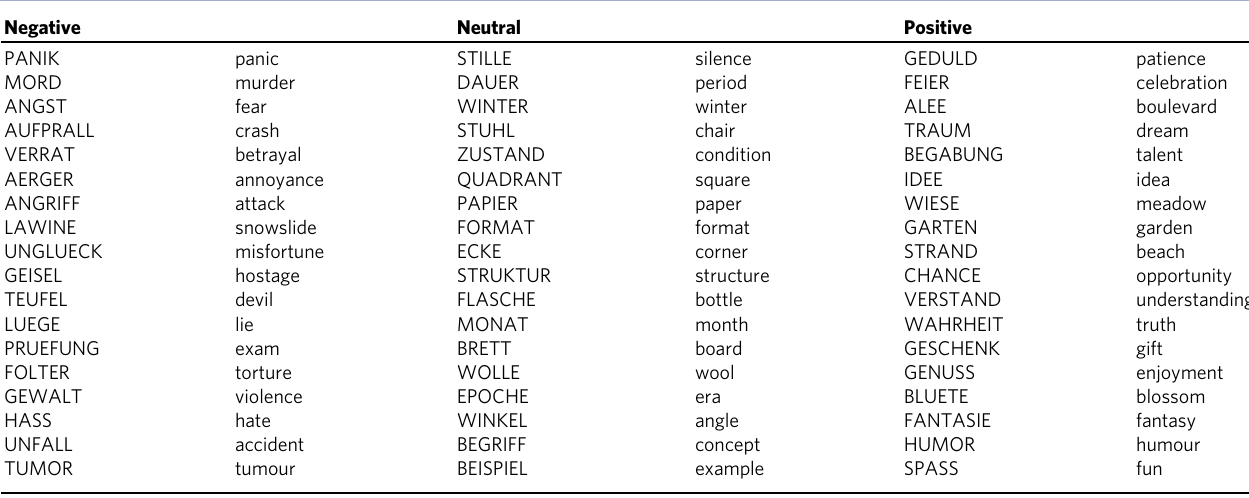
Note: German words in uppercase, English words in lowercase.